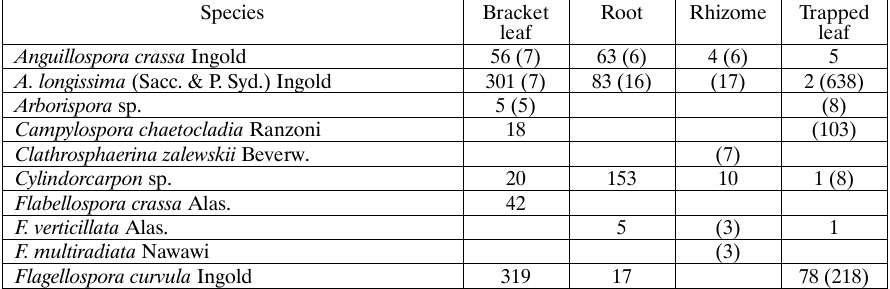
Water-borne hyphomycetes (conidia/g dry mass) recovered from tissues of Drynaria and trapped leaf litter in riparian trees of Konaje region during summer and monsoon (in parenthesis) (mean, n = 5) (different letters across the total conidia of each substrate between summer and monsoon indicate significant difference; P < 0.05; paited t